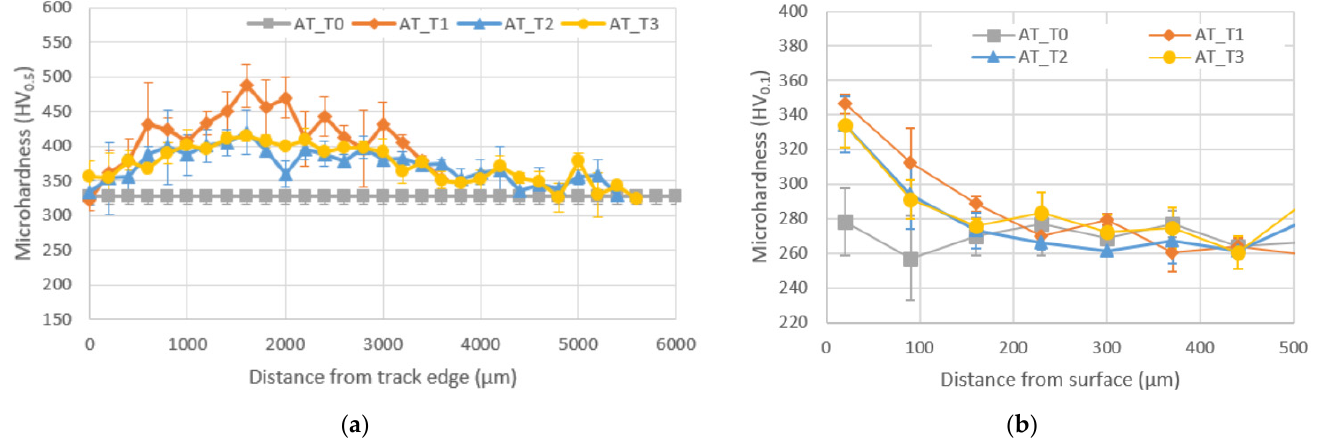
Figure 3. Microhardness results performed ( a ) on the surface of the tracks along their width and ( b ) on cross-sections for Ring AT.